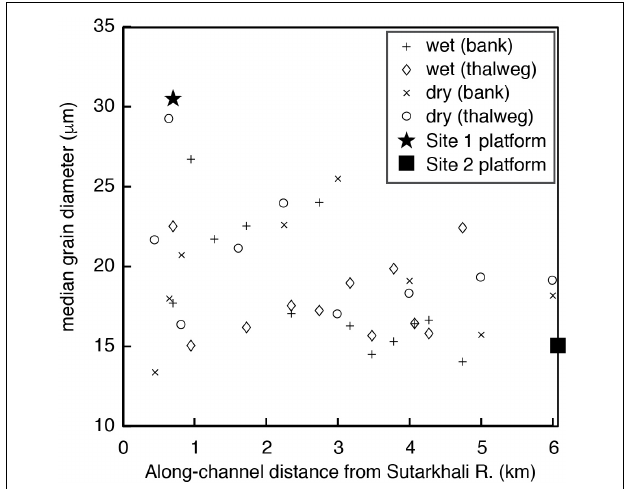
FIGURE 4 | Median grain diameter within the sub-basin plotted against distance from the Sutarkhali River, the conduit for both sediment and water. There is no obvious trend according to season or sample elevation within the channel, although there is a weak trend of decreasing grain size with distance